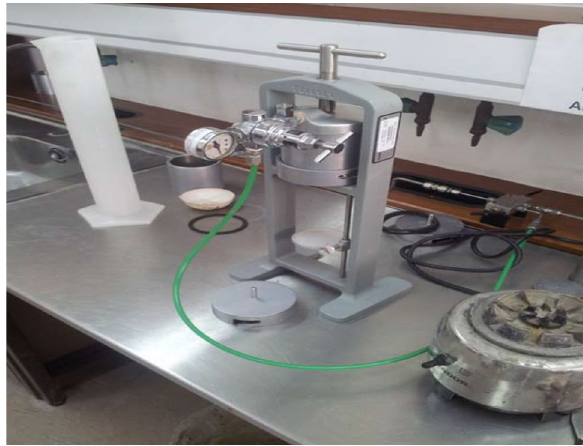
Fig. 2 Measurement of mud fluid loss